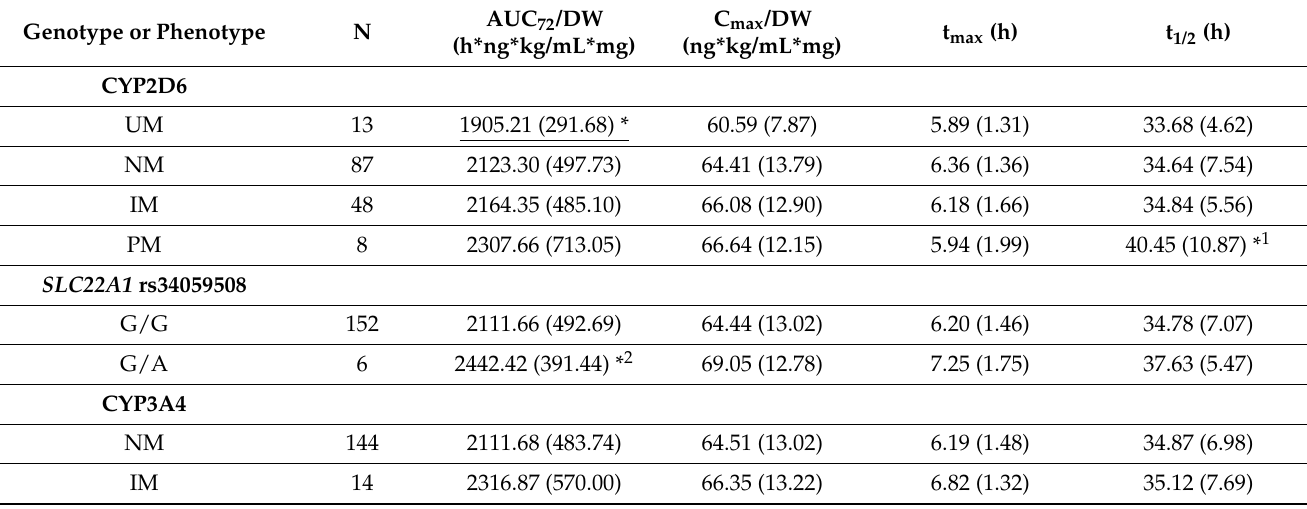
Table 5. Pharmacokinetic parameters regarding the genes analyzed in the confirmatory step.